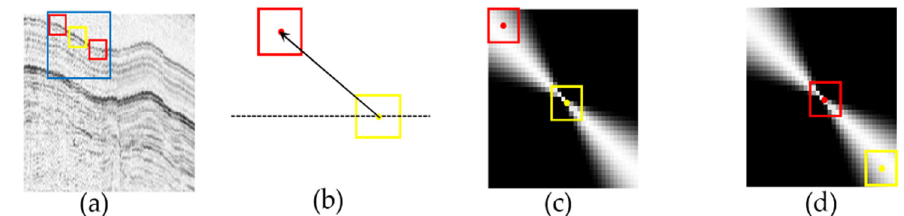
Figure 4. Illustration of the guidance weight, ( a ) shows the locations of the reference patch and the searching patches, ( b ) illustrates the relative direction between the reference patch and the searching patch, ( c ) and ( d ) visualize the functions Ψ ´ ( η ´ ) and Ψ ( η ), respectively.